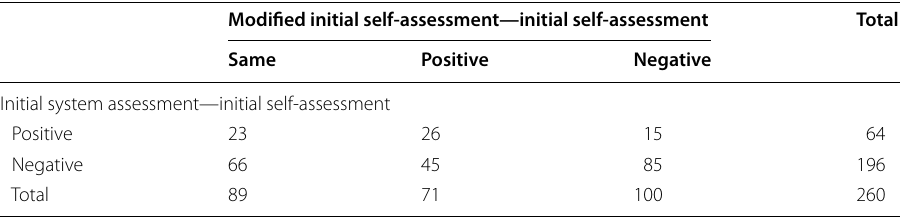
Table 12 Distribution of the students’ initial system assessment, initial self-assessment, and modified initial